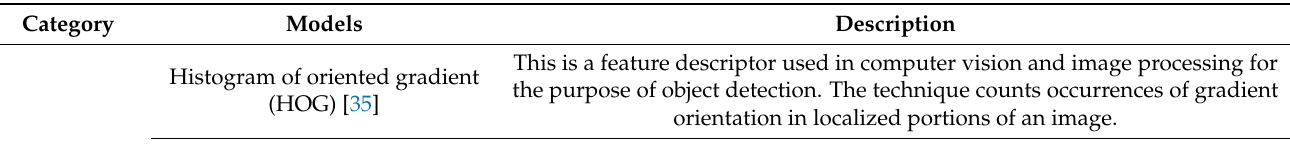
Table 1. Brief presentation of the feature extraction techniques, as well as the ML and DL models, and the main procedures that were reported in the papers of our